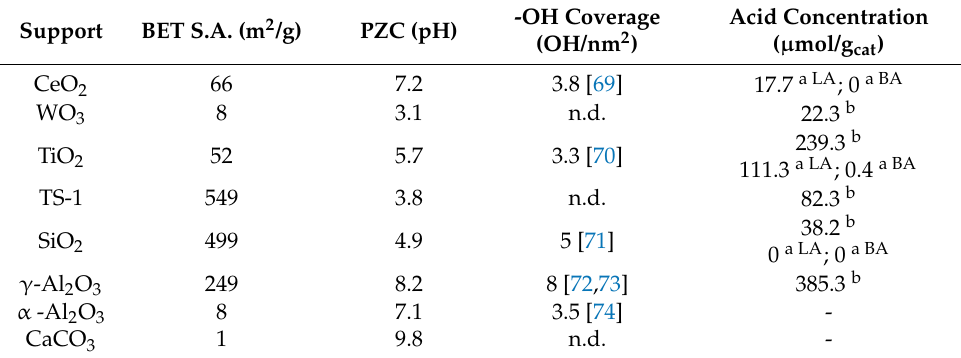
Table 2. Overview of the characteristics of the support materials used.